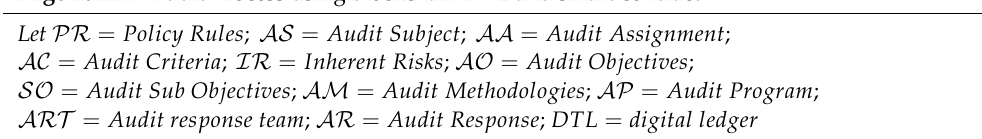
Algorithm 1 Audit Process using blockchain DTL and smart